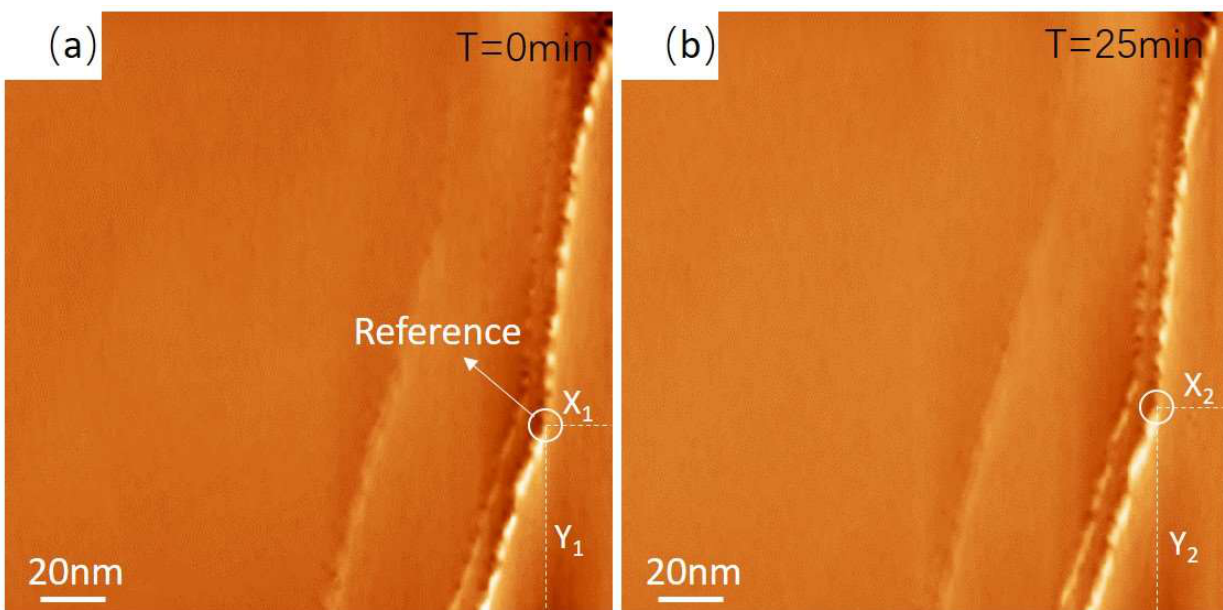
Figure 3. ( a ) Large area topography of large-sized graphite obtained with constant current mode; the reference dot is marked by a white circle. The tunneling current is 2.5 nA, and the scan speed is 1 lines/s. ( b ) Topography obtained by scanning the same area after 25 min.